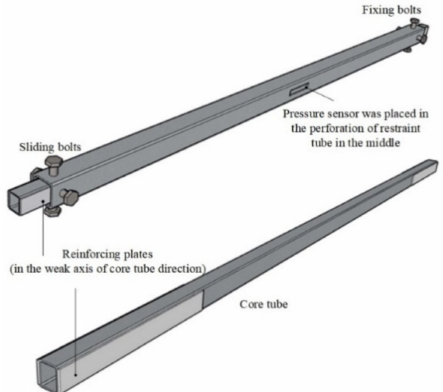
Figure 1. Buckling monitoring member specimen with reinforcing plates.